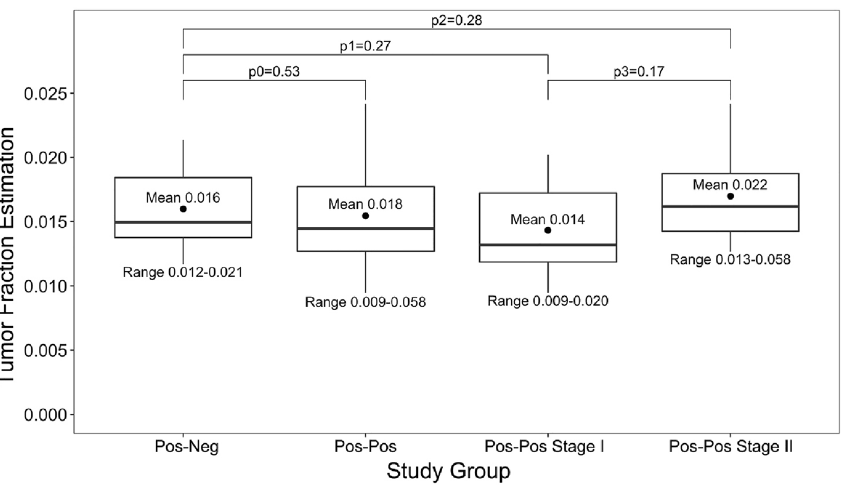
Figure 2. Distribution of tumor fraction estimation. p0 Pos-neg vs. Pos-pos, p1 Pos-neg vs. Pos-pos Stage I, p2 Pos-neg vs. Pos-pos Stage II, p3 Pos-pos Stage I vs. Pos-pos Stage II. p-value: Student t-test, Pos-Neg Positive– negative subjects, Pos-Pos Positive-positive subjects.